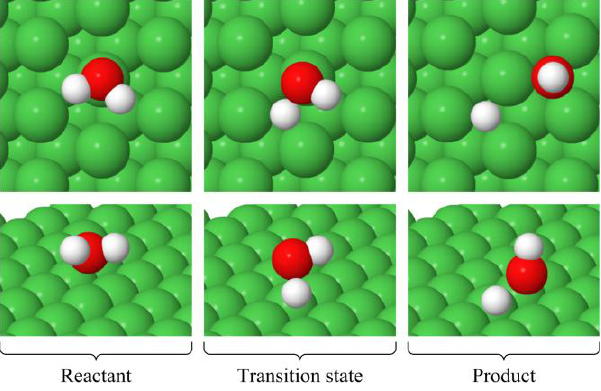
Figure 2. Minimum energy structures of the reactant, transition state and product for the H O * → OH * + H * reaction. 2